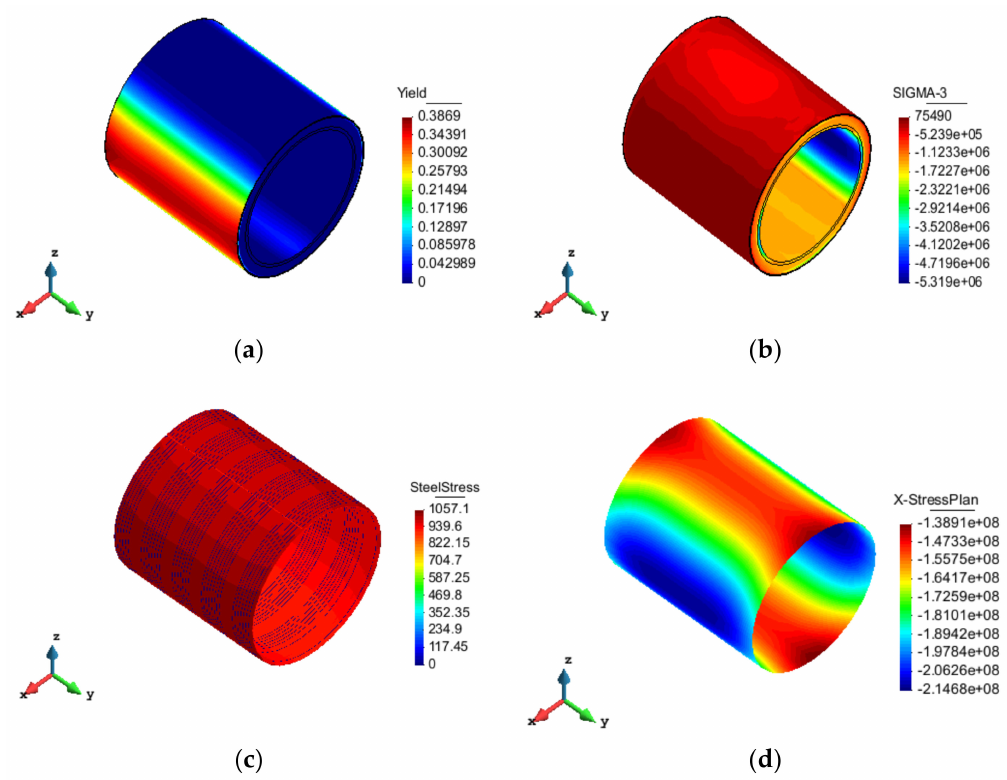
Figure 13. Nephogram of case 5: ( a ) damage, ( b ) 3rd principal stress, ( c ) wire stress, ( d ) cylinder